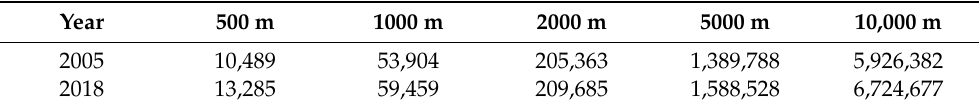
Table 7. Number of people living in the vicinity of the 7 sites